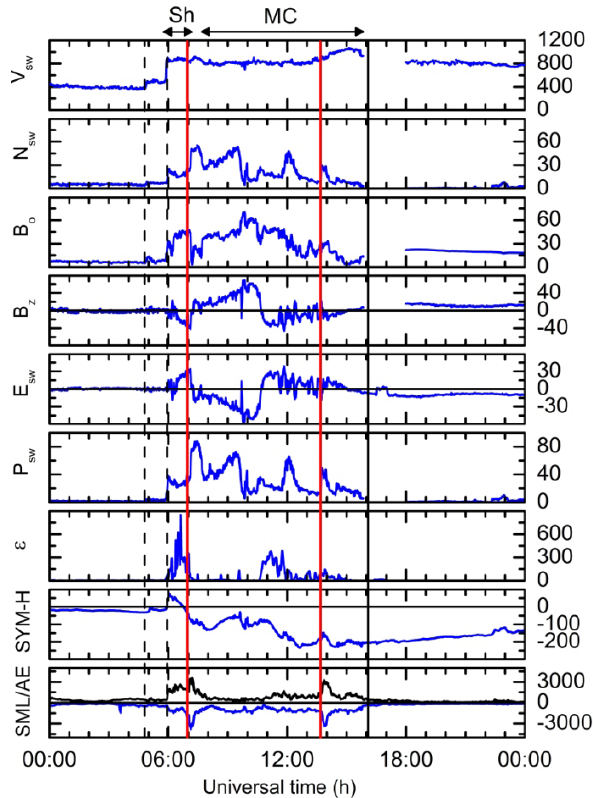
Figure 2. Interplanetary parameters during two SSS events occur- ring on 24 November 2001. From top to bottom, the panels are the solar wind speed ( V sw in kms − 1 ) , the density ( N sw incm − 3 ) , the interplanetary magnetic field (IMF) magnitude ( B o innT), the north–south component of the IMF ( B z innT), the interplanetary electric field ( E sw in mVm − 1 ) , the plasma ram pressure ( P sw in nPa), and the interplanetary epsilon parameter ( ε in 10 11 W). The next to the bottom panel contains the SYM-H (nT) indices. The bottom panel contains the ground SML (nT) indices (blue) and the AE indices (black). Onsets of two SSSs are indicated by ver- tical red lines during the complex magnetic storm on 24 November 2001. Interplanetary shocks are denoted by the dashed vertical black lines. A magnetic cloud (MC: Klein and Burlaga, 1982) is present and is shown bounded by solid vertical black lines. The MC lasted from ∼ 07:50 to ∼ 16:00UT. It is identified by the northward-then- southward rotation of the IMF B z